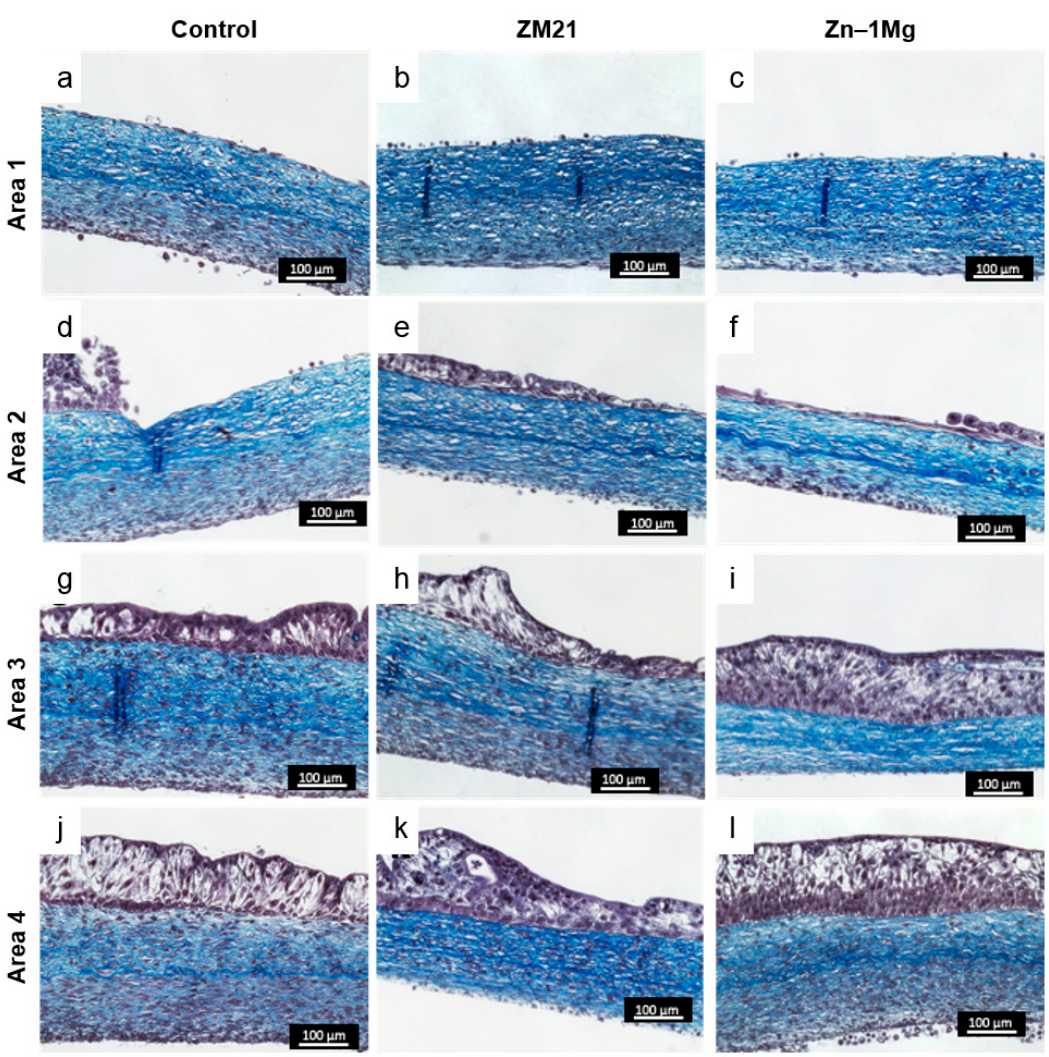
Figure 4. Histological analysis of UW tissue with di ff erent metal disks, stained with Masson’s Trichrome. Nucleus stained as purple and stroma / collagen stained as blue. Tissue sections are divided into four areas: ( 1 ) under / in contact with metal disks, ( 2 ) peri-metal site, ( 3 ) nearest area to peri-metal site, and ( 4 ) farthest area from peri-metal site. Bar = 100 µm.